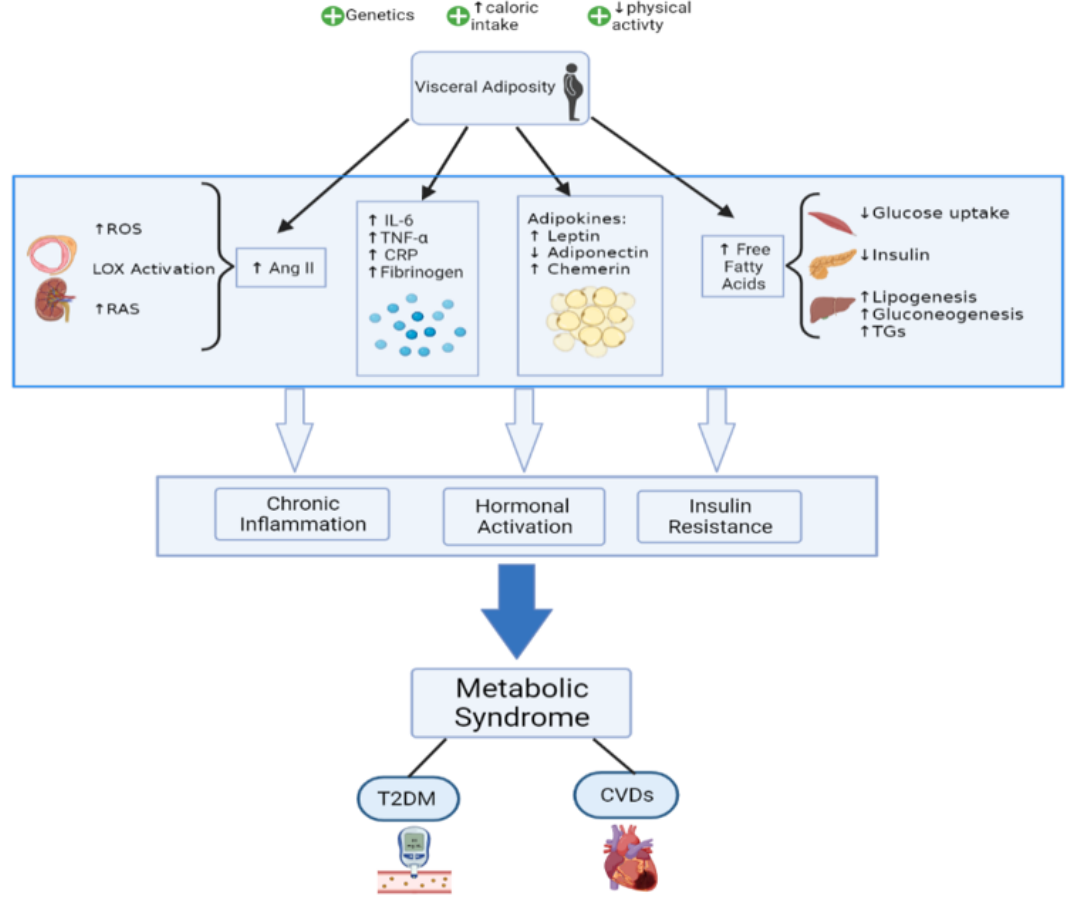
Figure 1. Mechanisms highlighting MetS